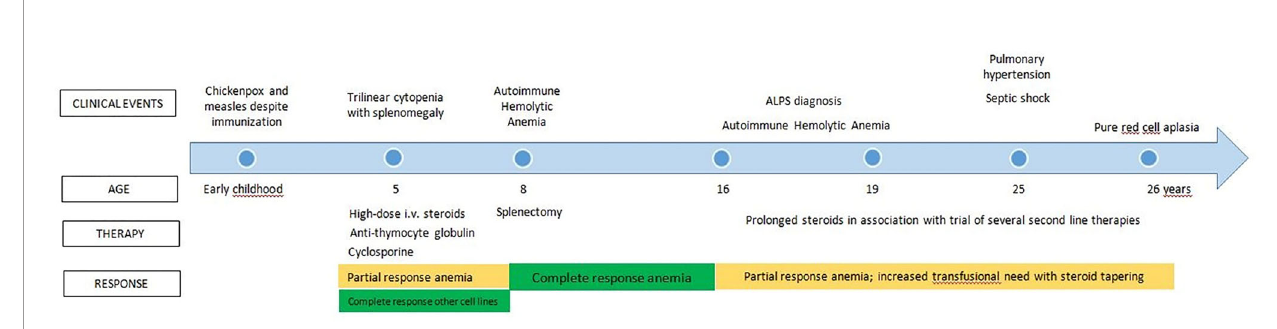
FIGURE 1 | Clinical history previous to referral at our